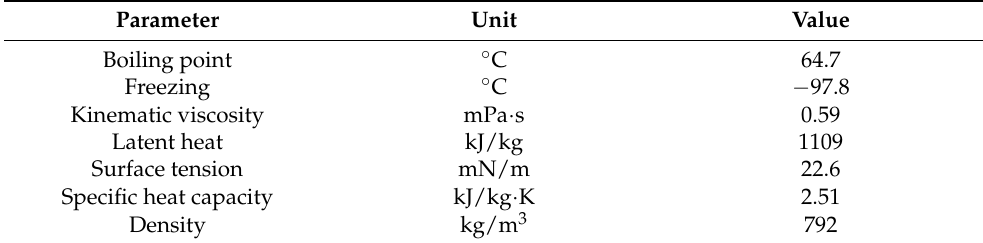
Figure 1. Schematic diagram of the pump-assisted capillary phase-change loop. Table 1. Thermophysical properties of methanol at room temperature and